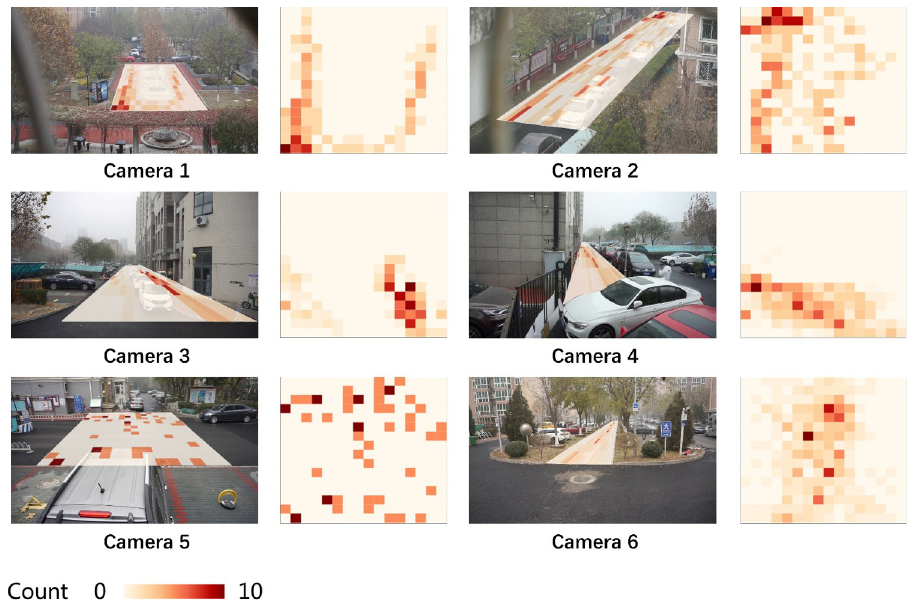
Fig 5. The usage of small public